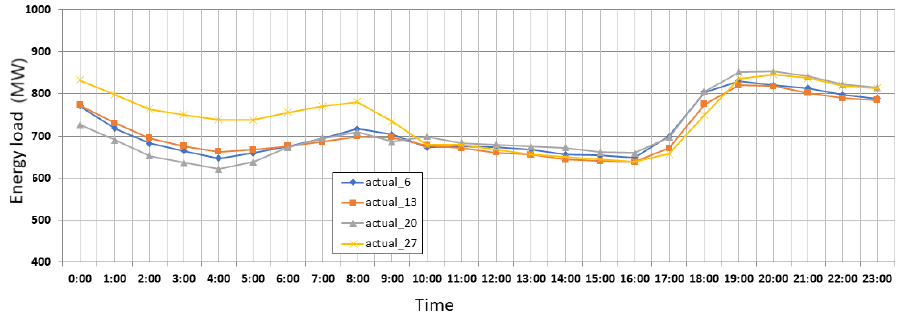
Figure 8. Energy consumption on Sundays in January 2019.